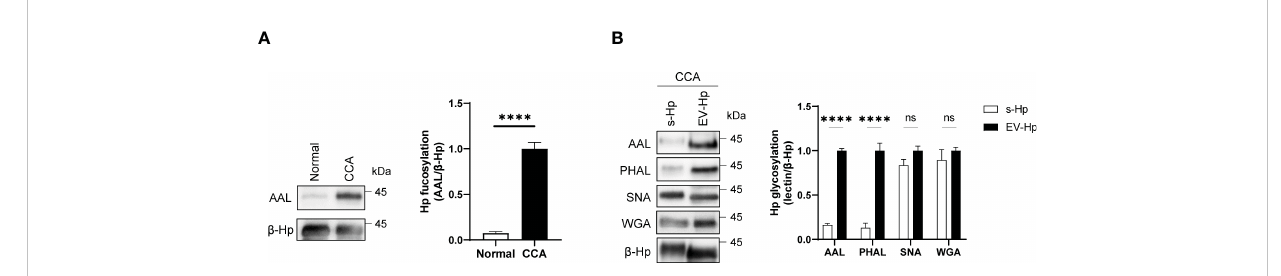
FIGURE 2 Glycosylation of EV-Hp is correlated with CCA. Quantitative data are shown as mean ± S.E.M. Statistical analysis was performed using the two-tailed Student ’ s t-test. ****p < 0.0001, ns p > 0.05. (A) AAL blotting for b -Hp puri fi ed from EVs; n = 6. (B) Lectin blotting for s-Hp and EV-Hp; n = 3. ns, not signi fi cant.